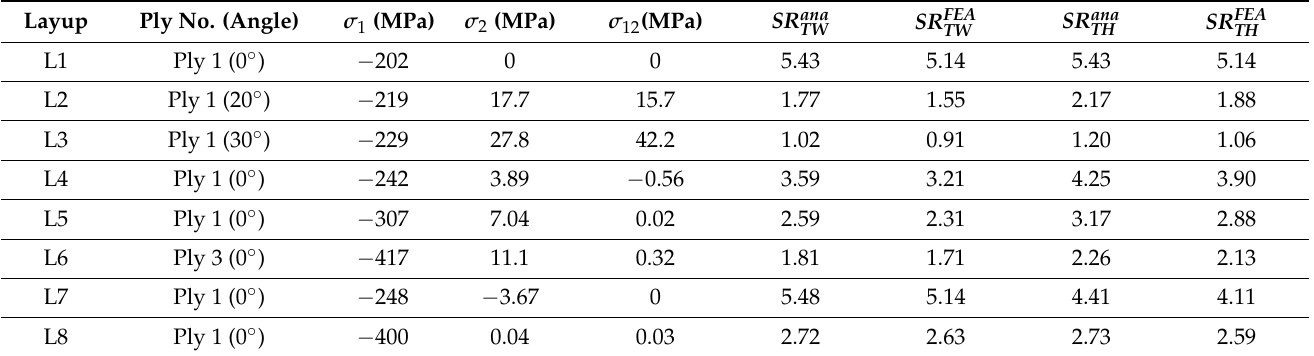
Table A4. Comparison of plies with minimum safety ratios (SRs) for the “III” beam (flange under compression; stress values are in MPa); see Figure 3c for a laminate stacking sequence sample.